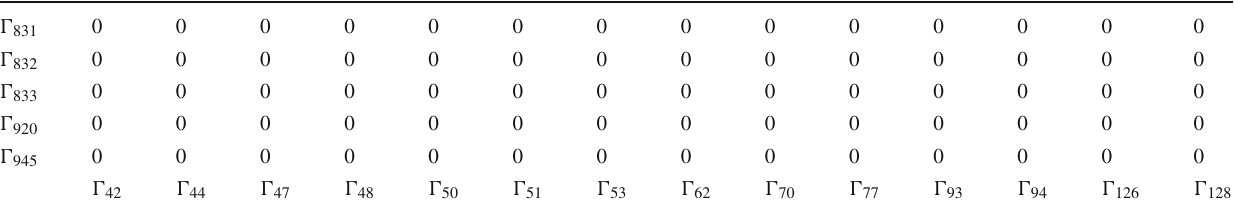
Table 311 Basis quantities correlation coefficients in percent, subtable